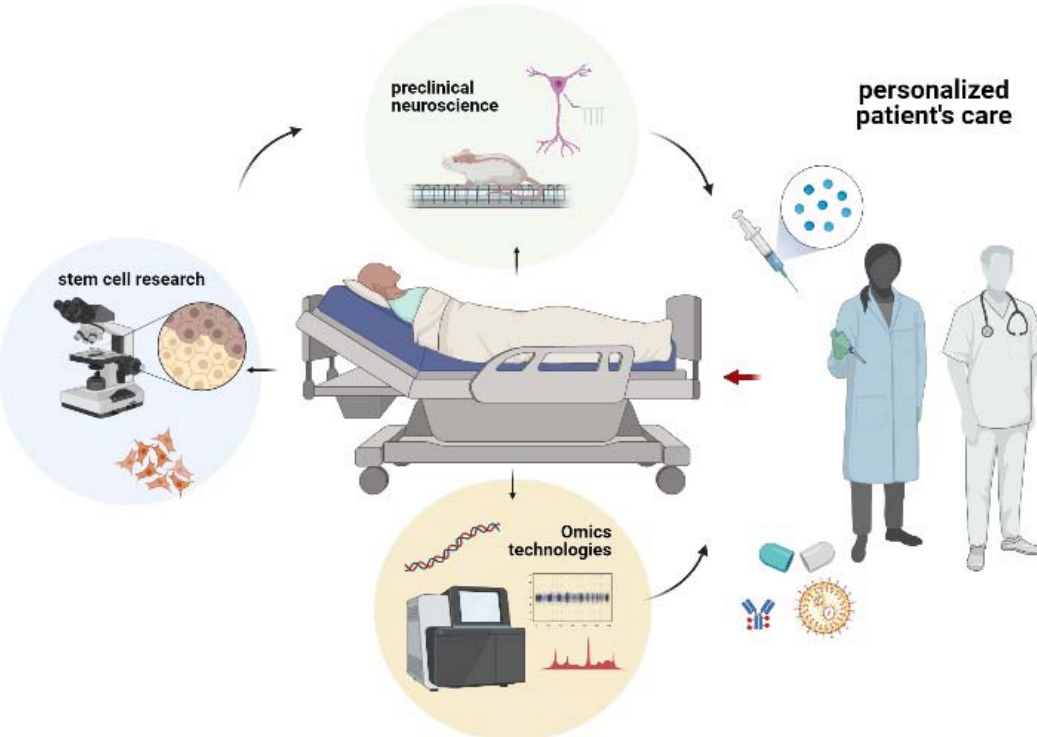
Figure 1. The figure schematizes how personalized medicine starts from basic and preclinical studies. In particular, somatic and stem cells from patients are studied as the source of information to dissect diseases at the basic level and develop cell-based treatments, omics technologies enable deciphering specific functional signatures and biomarkers in patient’s biospecimens, neuroscience research supports new technologies for understanding the conundrum of brain functioning and related disorders. Altogether, these three research areas contribute to the development of personalized cures and advanced therapies, enabling physicians with innovative tools for patient’s centered cures and care protocols. Created with BioRender.com (accessed on 2 March 2021).